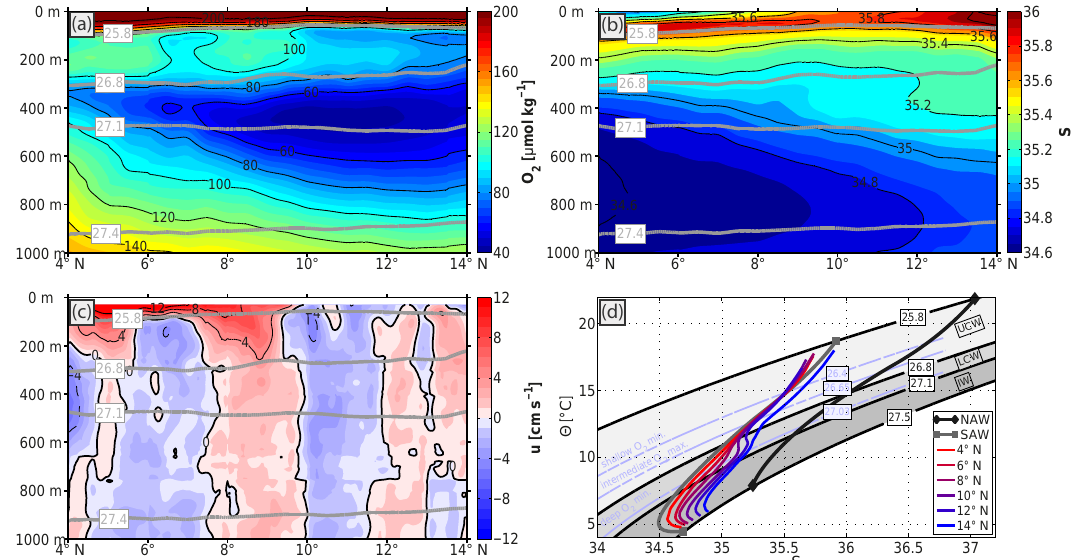
Figure 2. Mean sections of (a) oxygen, (b) salinity and (c) zonal velocity along 23 ◦ W between 4 and 14 ◦ N. Black contours denote isolines of the respective mean field. Gray solid contours mark mean surfaces of potential density inkgm − 3 . Note that no data of mean zonal velocity were derived for the upper 30m. (d) Mean θ - S characteristics for North Atlantic Water (NAW) and South Atlantic Water (SAW) and for different latitudes along 23 ◦ W (details of reference regimes for NAW and SAW are given in the text). Data from about the upper 100m of the water column were excluded. Black solid lines denote isopycnal surfaces, which define the different water mass regimes for UCW (upper central water), LCW (lower central water) and IW (intermediate water). Blue dashed lines denote isopycnal surfaces, which define different oxygen regimes with respect to the mean vertical oxygen profile in the